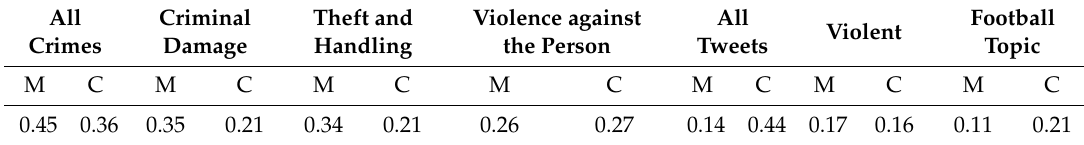
Table 3. Spatial Autocorrelation Moran’s I.